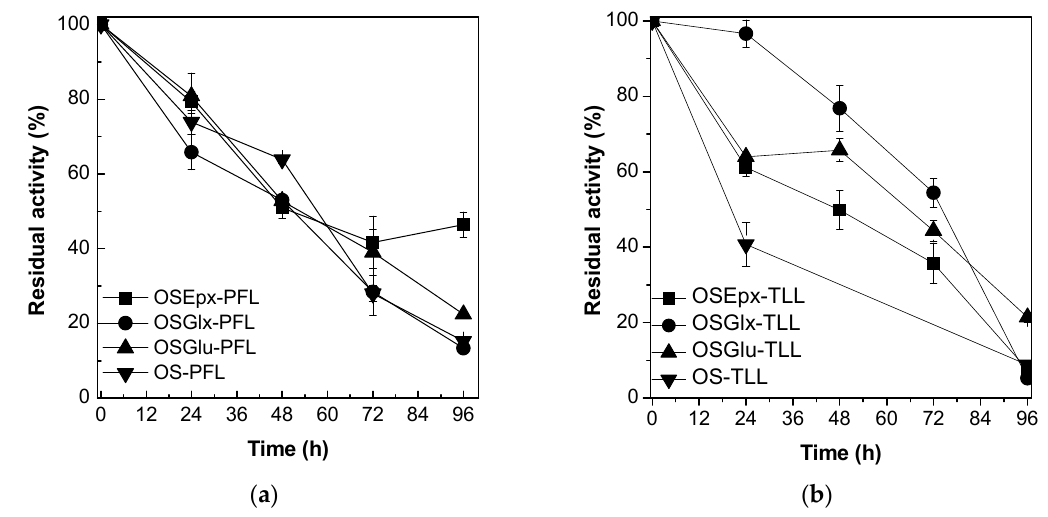
Figure 2. Residual activities of immobilized PFL ( a ) and TLL ( b ) on silica ‐ based supports at 65 °C incubated in tert ‐ butyl alcohol.